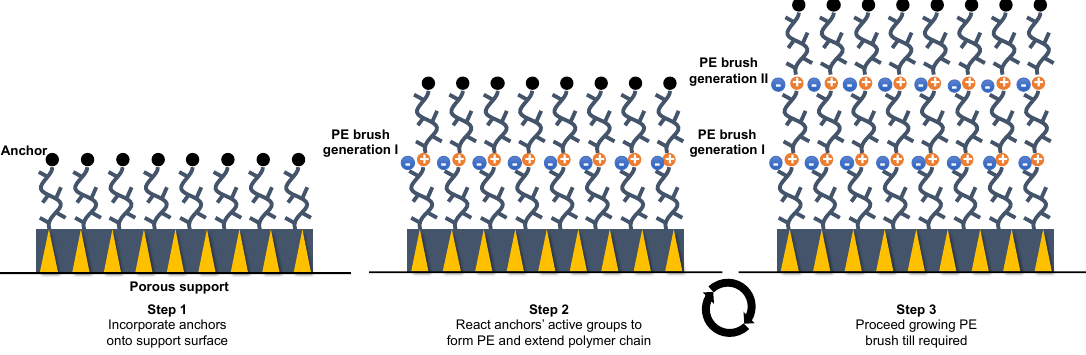
Figure 8. Film membranes Chemical layer deposition via grafting